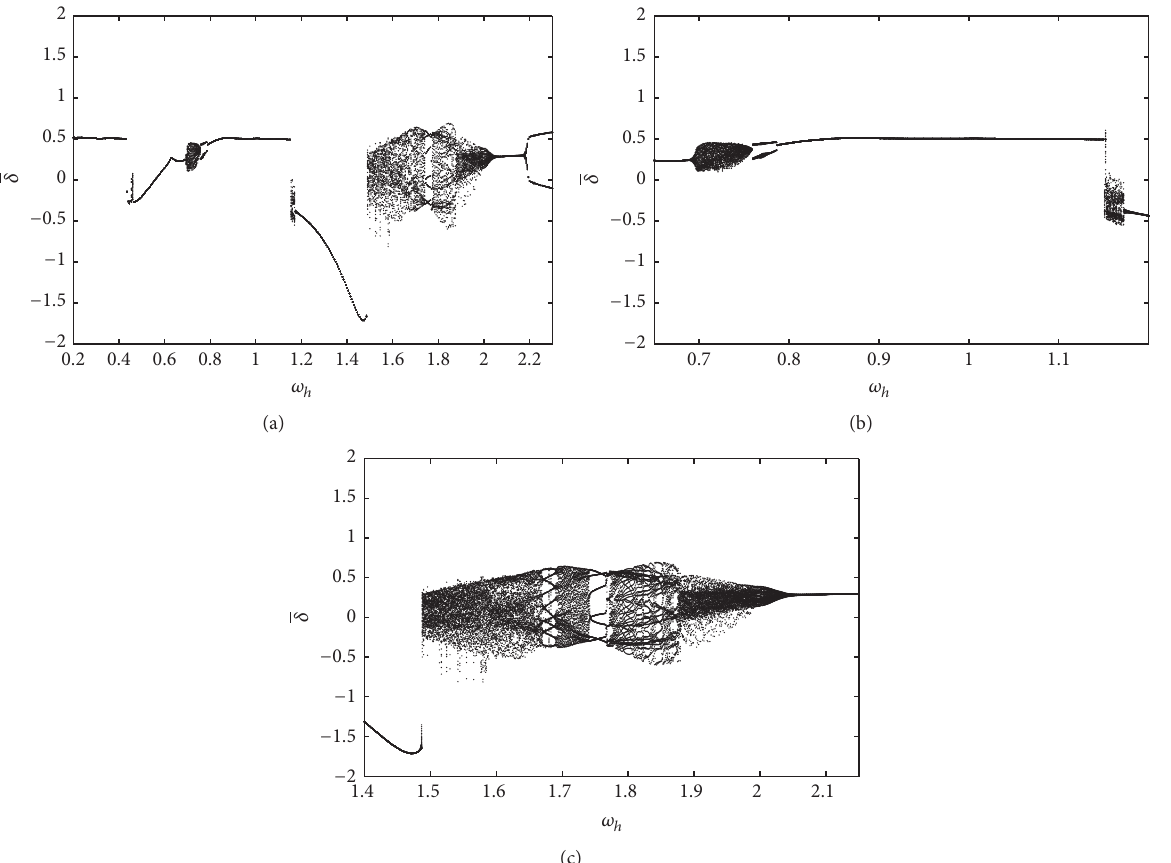
Figure 2: Bifurcation diagrams using 𝜔 ℎ as control parameter: (a) general view 𝜔 ℎ = 0.2 ∼ 2.3; (b) enhanced view 𝜔 ℎ = 0.65 ∼ 1.2; (c) enhanced view 𝜔 ℎ = 1.4 ∼ 2.15.